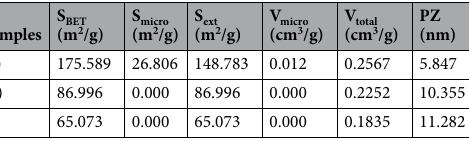
Table 1. Structural characteristics of (a) raw attapulgite, (b) Sb 2 Se 3 -Sb 2 O 3 -attapulgite nanocomposites and (c)